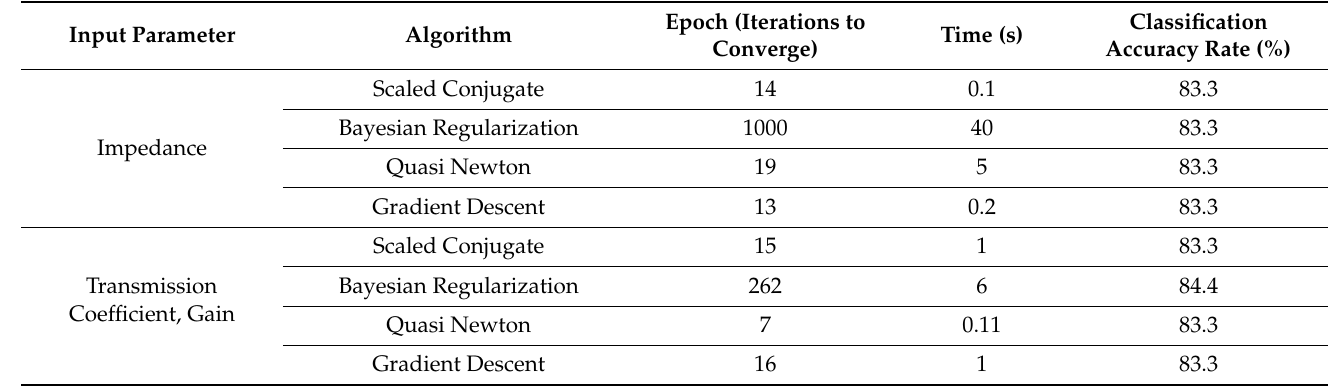
Table 6. Classification Performance between crack widths.